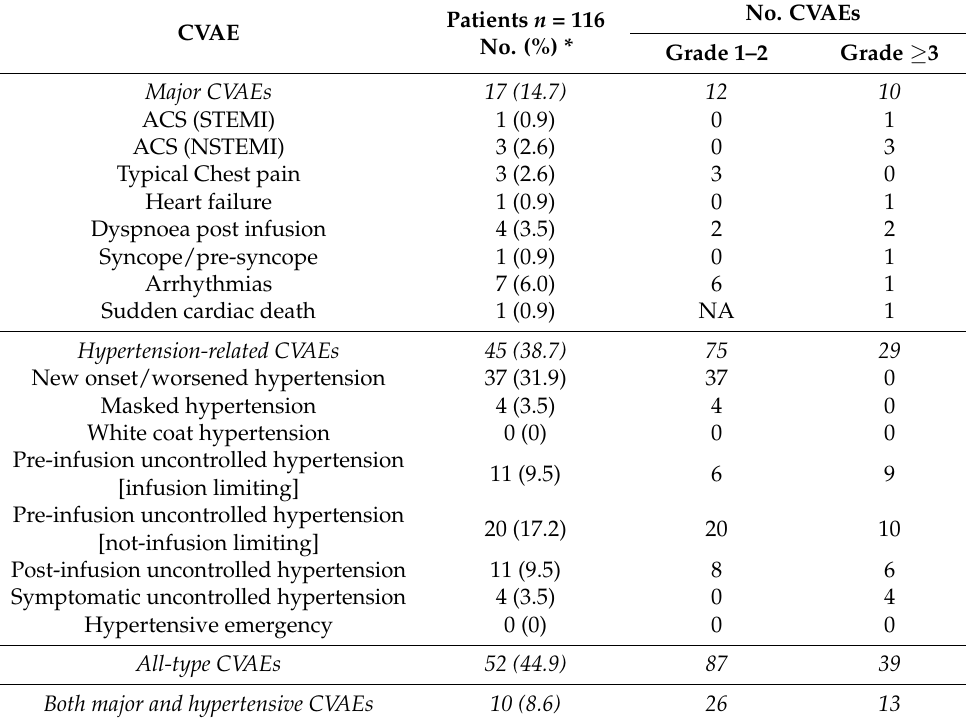
Table 2. Lists of all-types of CVAE, major CVAEs and hypertension-related